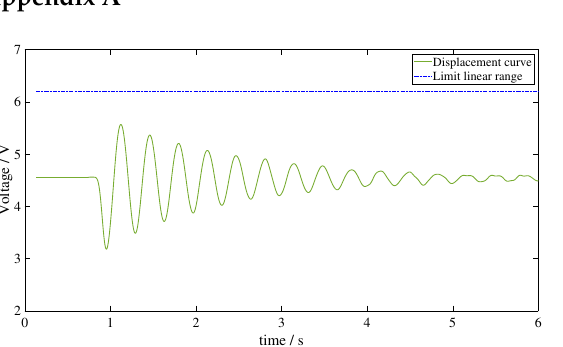
Figure A1. Resulting exponentially decreasing sinusoidal curve (green) and limit for the linear viscoelastic regime (blue). Adapted from Vizcaíno-Vergara et al.